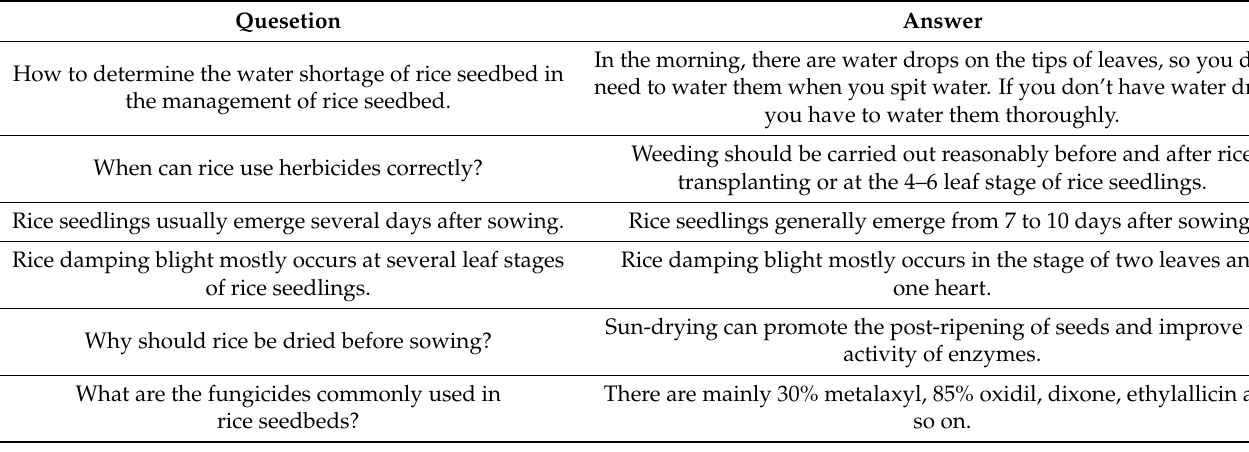
Table 1. Sample of rice-related Q&A pair